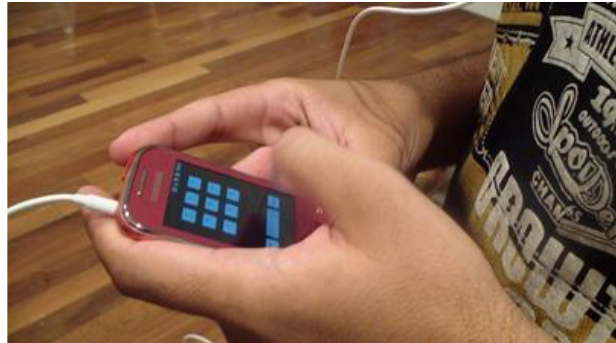
Figure 2. A subject performing creative activities